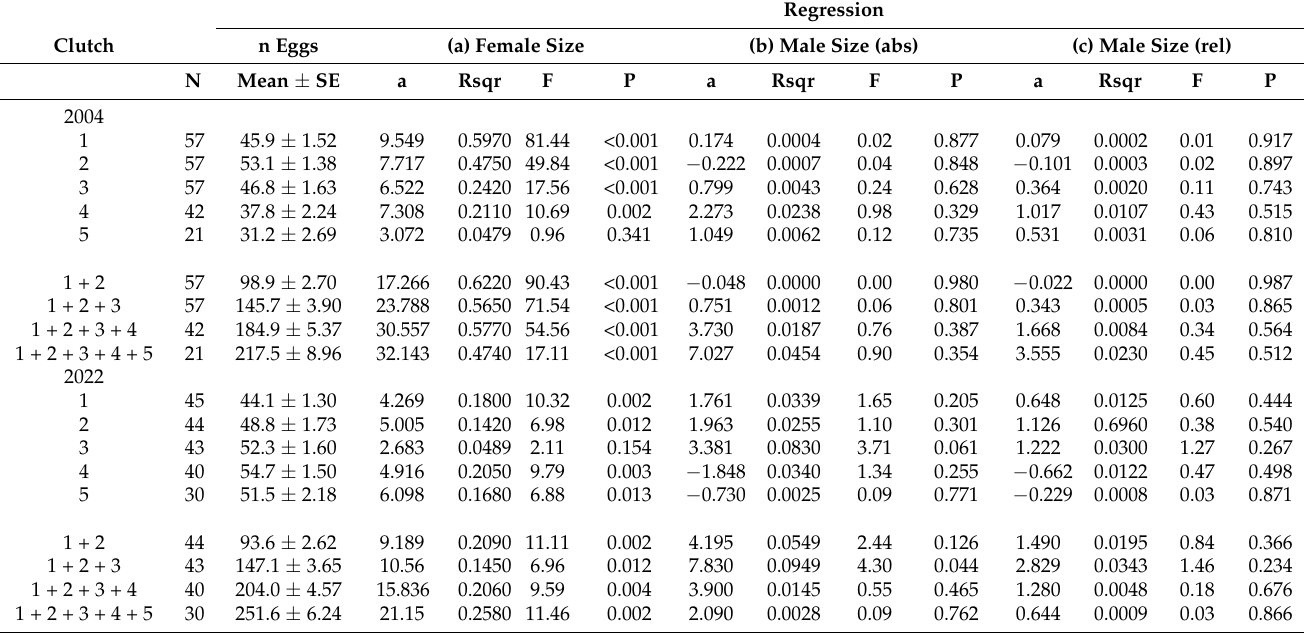
Table 2. Relationship between body size and number of eggs deposited in the first five clutches, in the experiments of 2004 and 2022. Clutch: clutch order - the clutches of the particular order and aggregated numbers of eggs laid from the beginning of oviposition up to the deposition of the clutch of the particular order (e.g., 1+2 indicates aggregated number of eggs in clutches 1 and 2, etc.), N: the number of females that laid clutches of the particular order. Regression: (a) Female size: regression of number of eggs on female body length (mm). (b) Male size (abs): regression of the residuals of regression (a) on “absolute male size”, which is male body length (mm). (c) Male size (rel): regression of the residuals of regression (a) on “relative male size”, which is the difference between male and female body length (mm). a: slope of the regression line, Rsqr: coefficient of determination of the regression line, F: F statistic of the ANOVA test, P: P value of the ANOVA test.